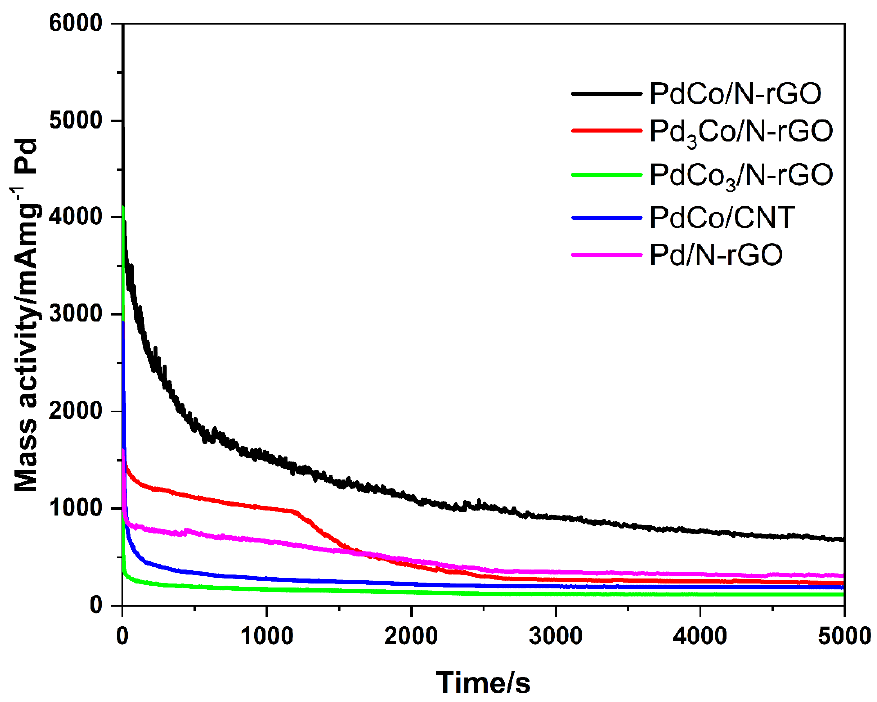
Figure 8. Chronoamperometry of the catalysts in 0.5 M H 2 SO 4 and 0.5 M HCOOH solutions at 0.35 V for the catalysts after 5000 s.